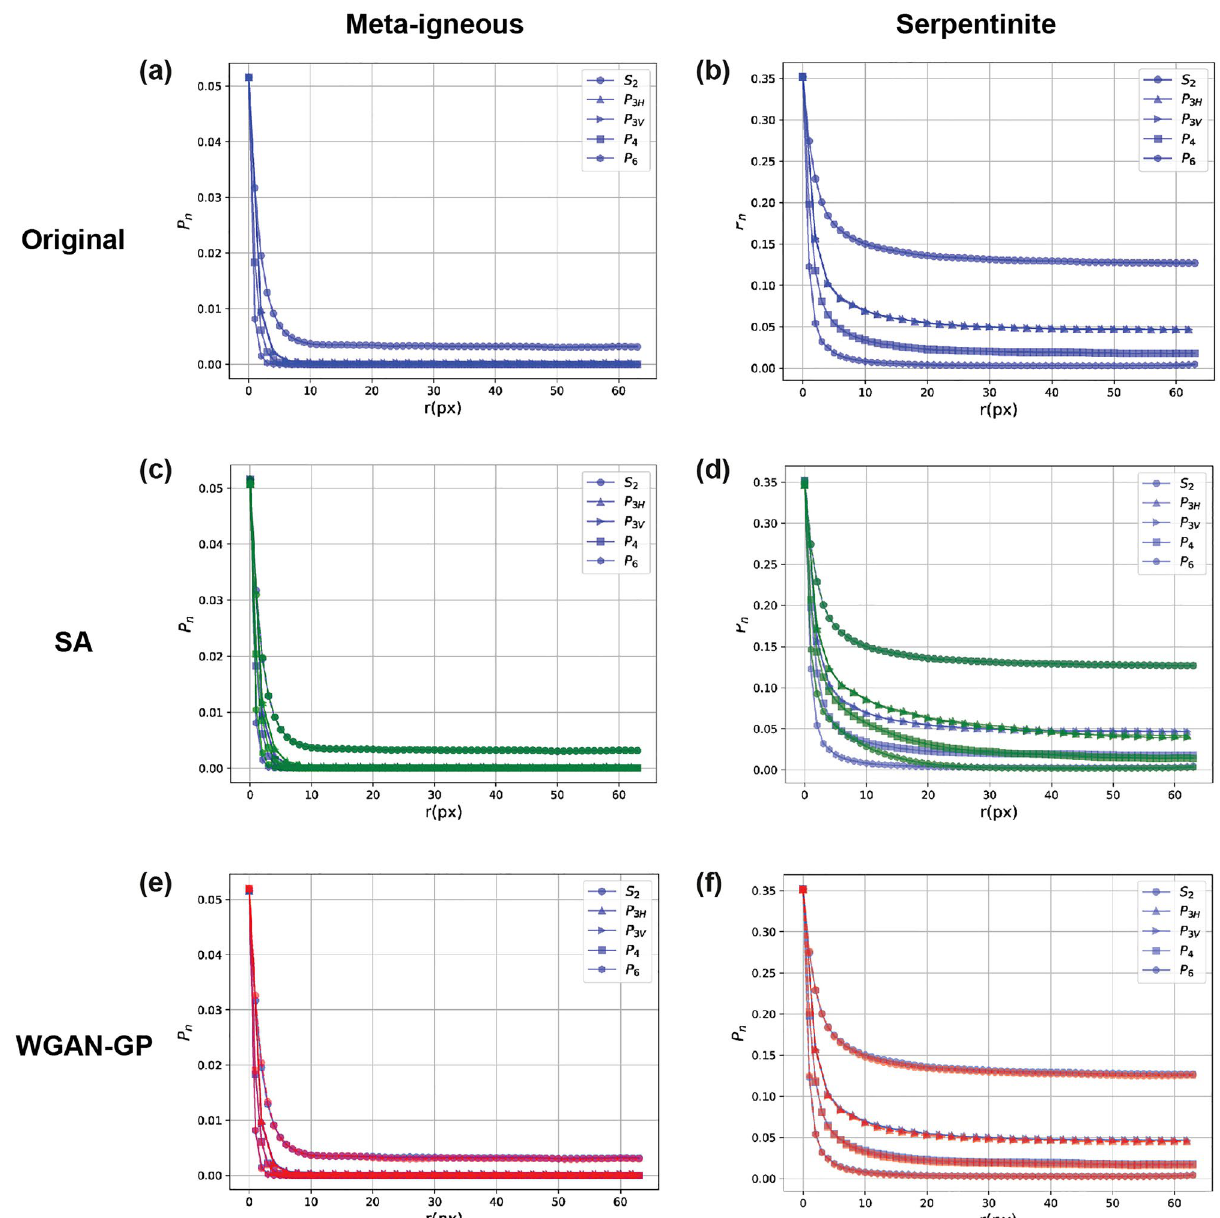
Figure 4. Evaluation of reconstruction performance using SMDs. Quantification of original ( a , b ) and reconstructed microstructures using SA ( c , d ) and WGAN-GP ( e , f